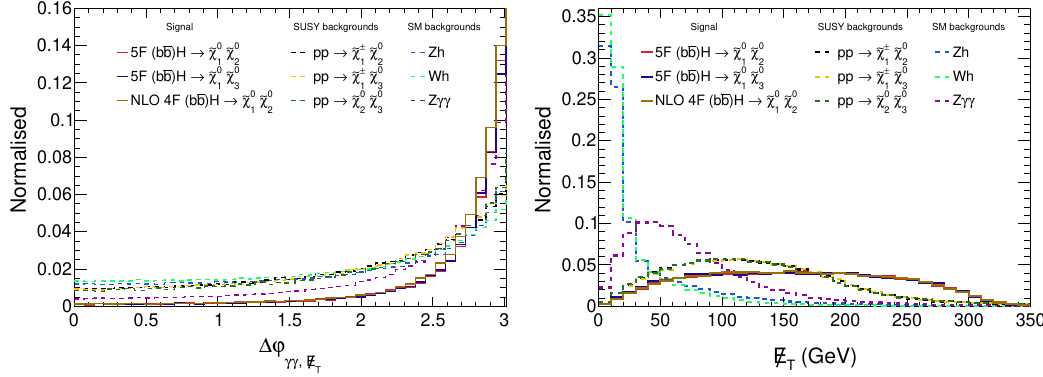
channel for the cut-based analysis. T